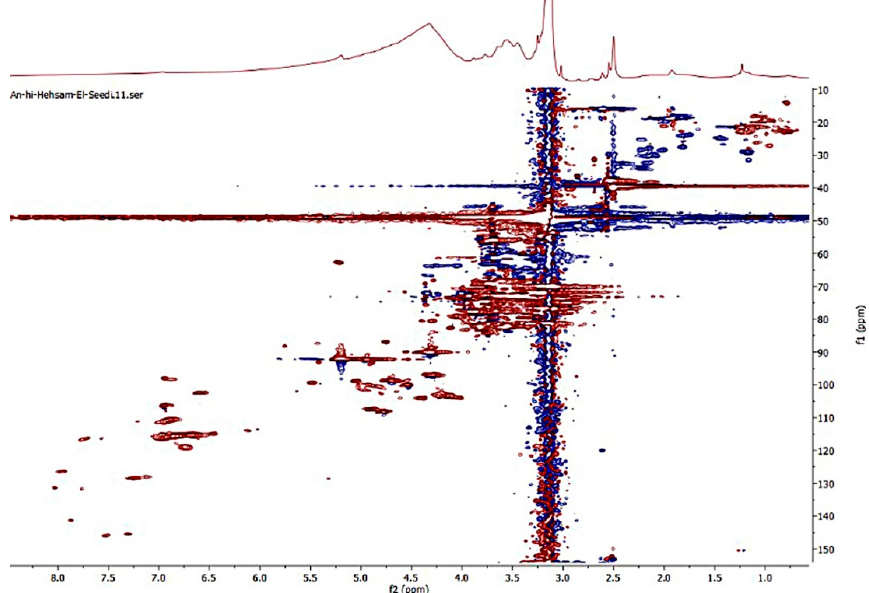
Figure 4. HSQC spectrum of A. hierochuntica methanolic extract.